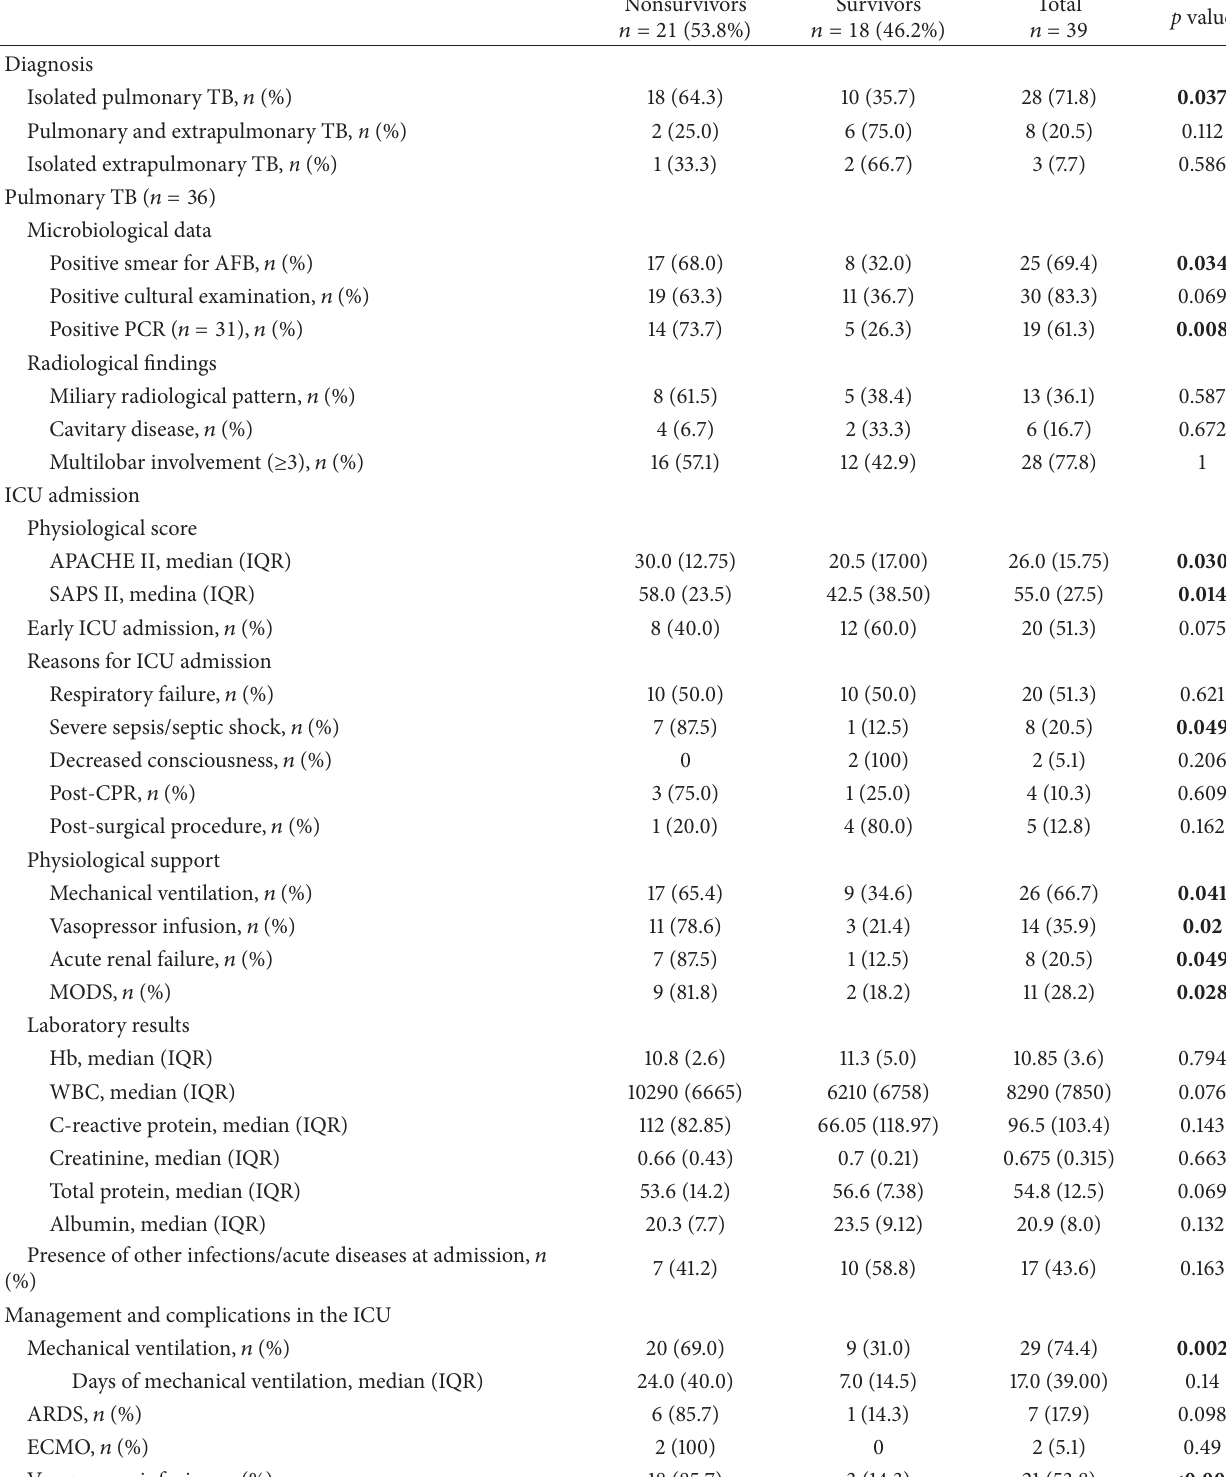
Table 2: Risk factors for in-hospital mortality using univariate